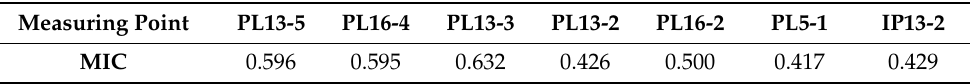
Figure 11. Relationship between the deformation of representative monitoring points and variation of reservoir water level. Table 4. Zoning results of deformation measuring points of the ultra-high arch dam during the third phase.